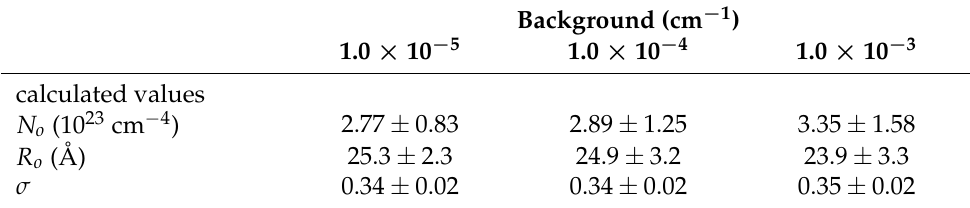
Table 3. Calculated values of the three parameters of the lognormal SDF of spherical inhomogeneities obtained by the SPA of the simulated SCS with the backgrounds added to the case of σ = 0.4.